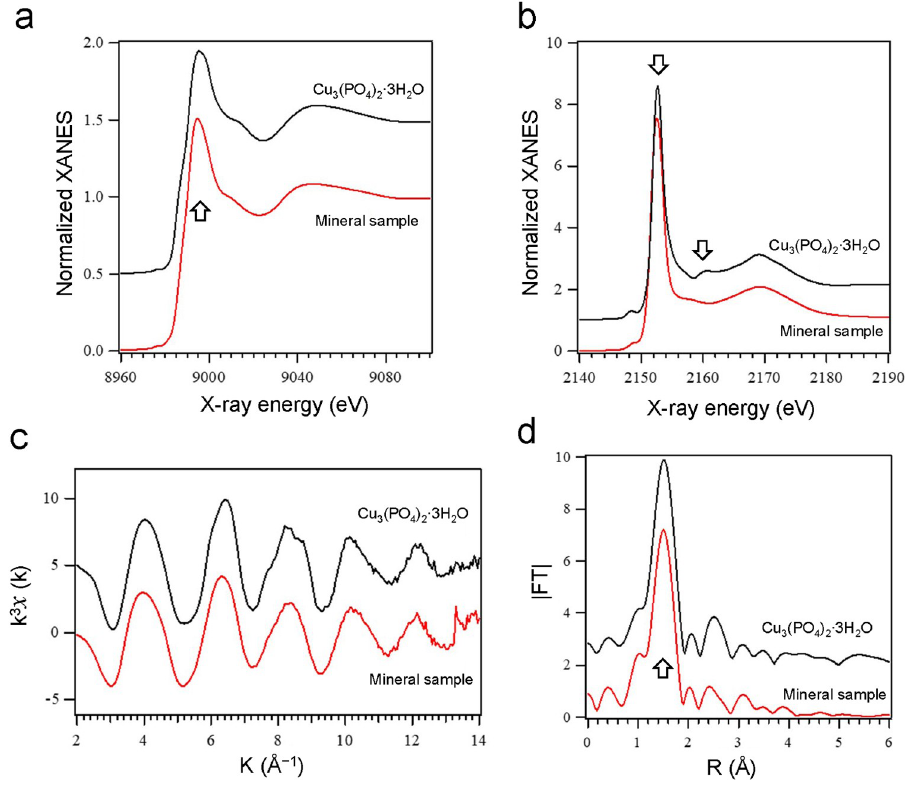
Fig 3. XANES and EXAFS spectra of the minerals formed on the phosphorylated yeast cells. Yeast cell samples were collected on Day 6 of Cu 2+ adsorption. Copper (II) phosphate (Cu 3 (PO 4 ) 2 � 3H 2 O) was used as the standard. (a) Cu K-edge XANES (b) P K-edge XANES (c) Cu K-edge EXAFS (d) Radial structure function (RSF).